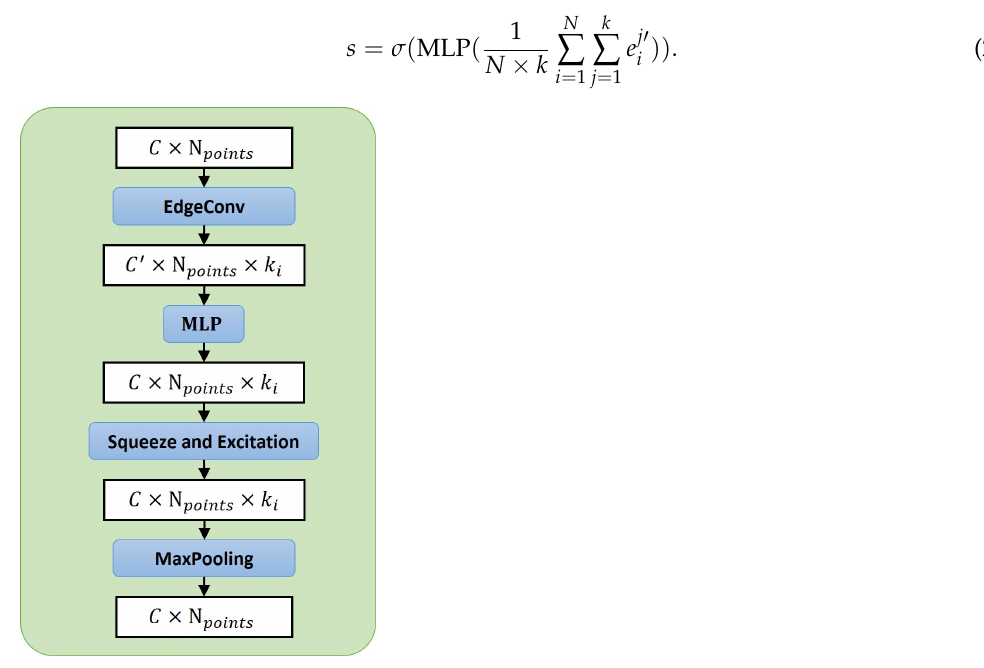
Figure 8. This is the Singe-Scope Module (SSM) which is the main module in our MSA module. Each SSM module is assigned a different k value k i in one MSA